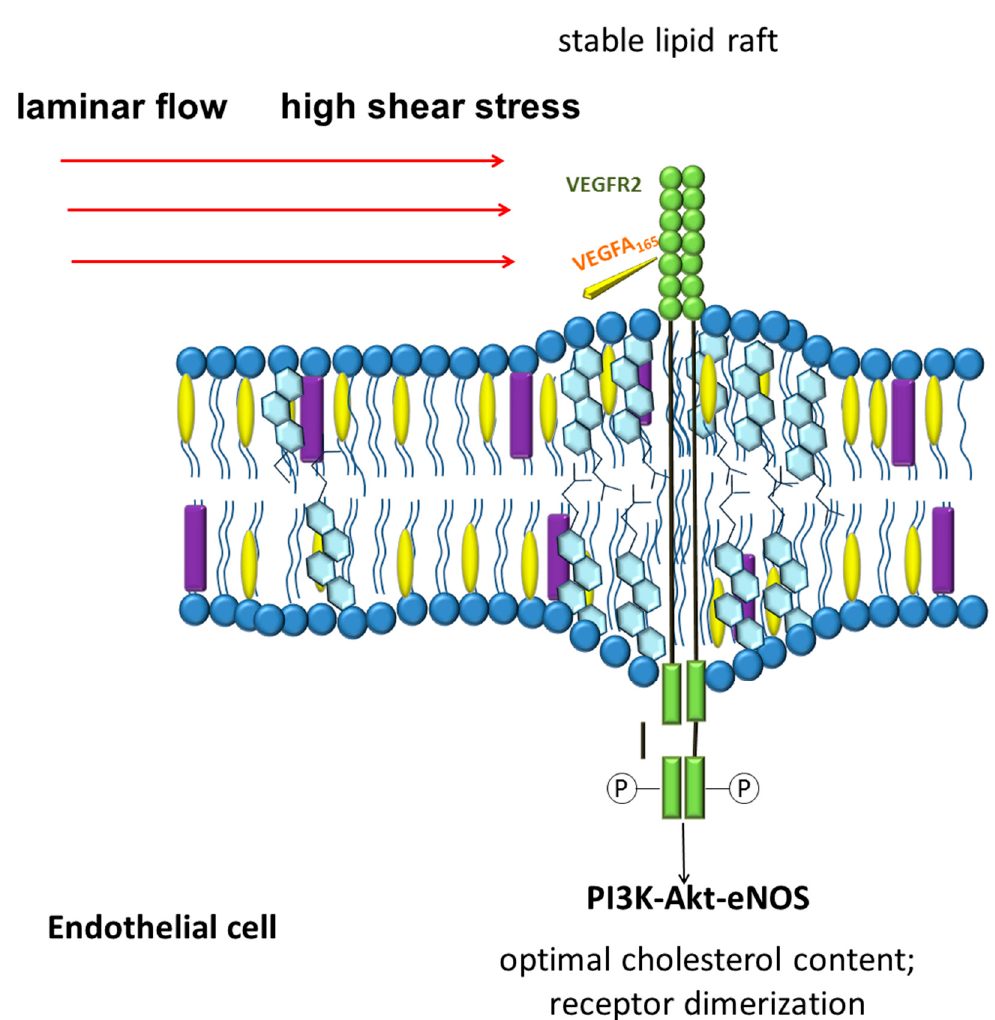
Figure 2. Schematic demonstrating the involvement of VEGFR2 in cross-linking blood flow characteristics and ligand-associated receptor activation. Stabilization of lipid rafts promotes receptor dimerization. Laminar blood flow promotes phosphorylation of VEGFR2.